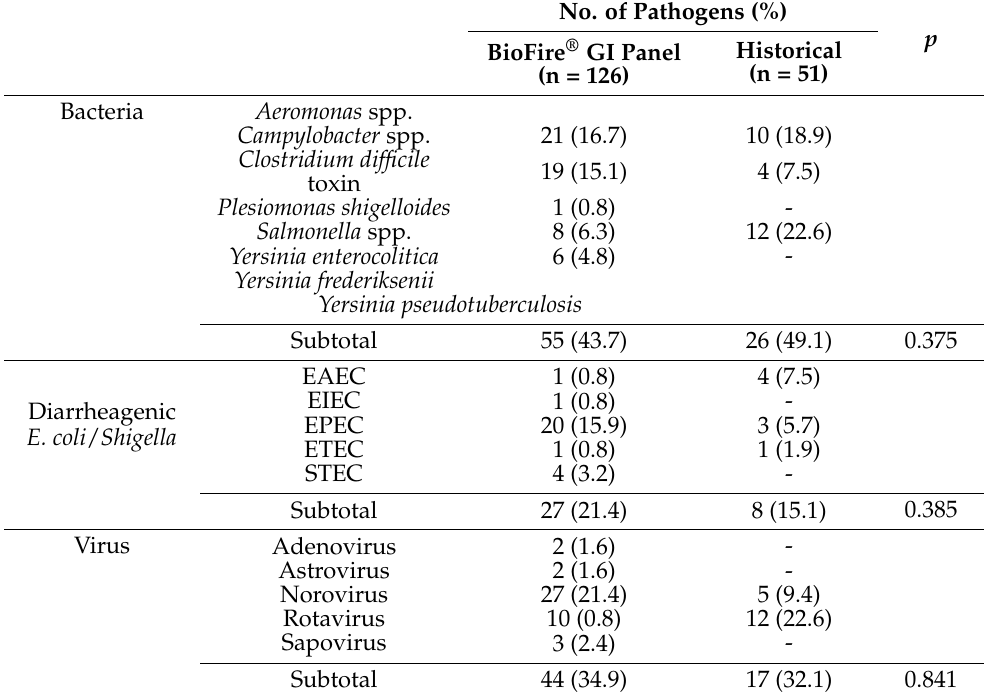
Table 3. Pathogens detected in prospective cohort by BioFire ® GI Panel and historical cohort with community-onset diarrhea.